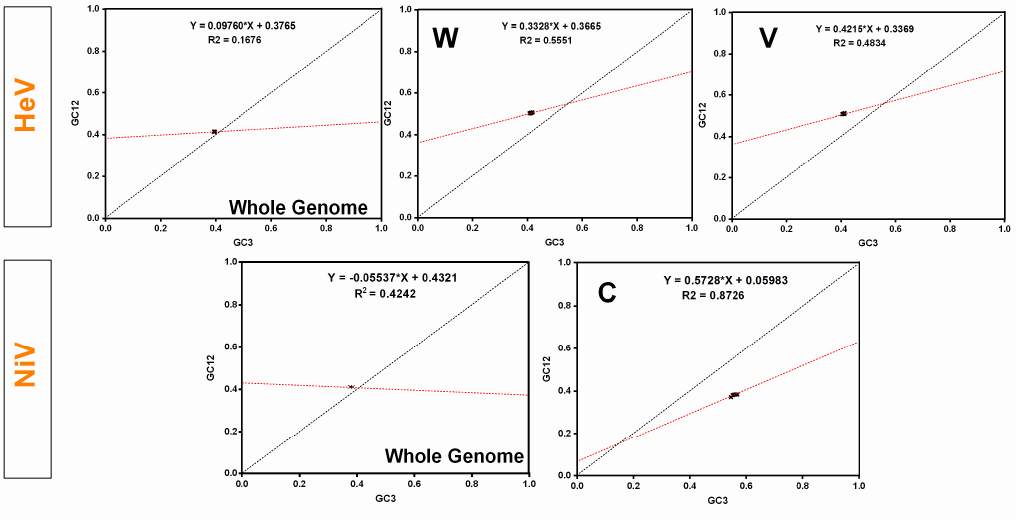
Figure 5. Neutrality plots for the entire coding sequences of HeV and NiV. In neutrality plots, GC12 of different virus isolates were plotted against GC3. The linear regression of GC12 against GC3 is presented by a red-dotted line (HeV—Y = 0.06900*X + 0.3877, R 2 = 0.0339; NiV—Y = −0.05536*X + 0.4321, R 2 = 0.424).